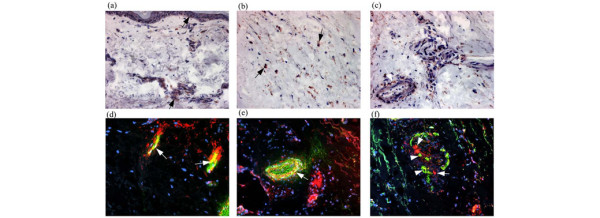
Distribution of proliferating cells in normal and dcSSc skin. Cryosections from (a) normal and (b,c) dcSSc were stained with an anti-PCNA antibody. In normal skin, PCNA immunostaining was restricted to cells within the epidermis and sweat glands ((a,b) arrows). In two out of ten dcSSc samples, PCNA was detected in fibroblastic cells ((b) arrows) and in microvessels ((c) arrows). Double immunofluorescence labelling of dcSSc skin: cryosections were double stained with a combination of antibodies against (d,e) PCNA and α-SMA and (f) PCNA and PAL-E. PCNA is labelled with Texas Red while α-SMA and PAL-E are labelled with FITC. Colocalization was detected with PCNA and α-SMA antibodies within the microvasculature ((d,e) arrows, yellow colour). When used in combination with PAL-E, PCNA-labelled cells ((f) arrows) were predominantly located adjacent and abluminal to endothelial cells ((f) arrowheads). Original magnification × 20. α-SMA, alpha smooth muscle actin; dcSSc, diffuse cutaneous systemic sclerosis; PCNA, proliferating cell nuclear antigen; FITC, fluorescein isothiocyanate.